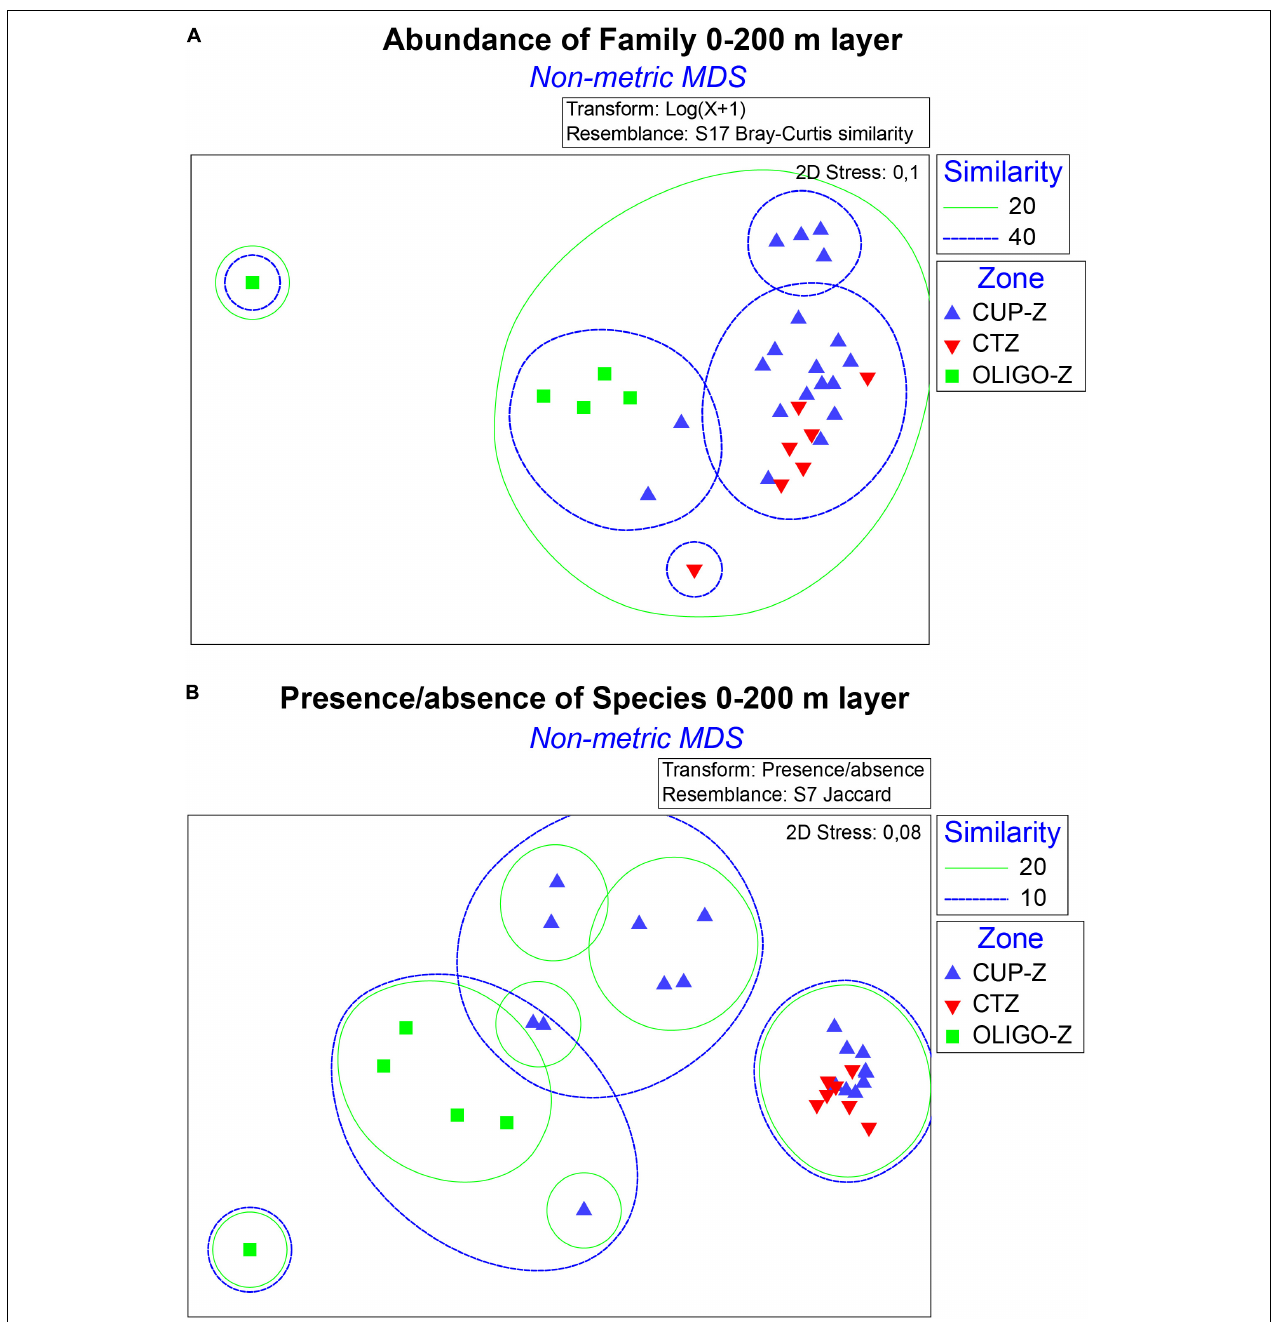
FIGURE 4 | Non-metric multidimensional scaling diagram (NMDS) of families and species within the order Calanoida found in the 0–200 m layer, across an onshore-offshore gradient, divided in zone which were defined as: coastal upwelling zone (CUP-Z), mesotrophic coastal transition zone (CTZ) and oligotrophic zone (OLIGO-Z) of the southeast Pacific. For families NMDS (A) was calculated using its abundance through the Bray-Curtis distance index from the transformation of data with log (x + 1). For species NMDS (B) was calculated using the Jaccard distance index from the transformation of the abundance data as presence/absence of the